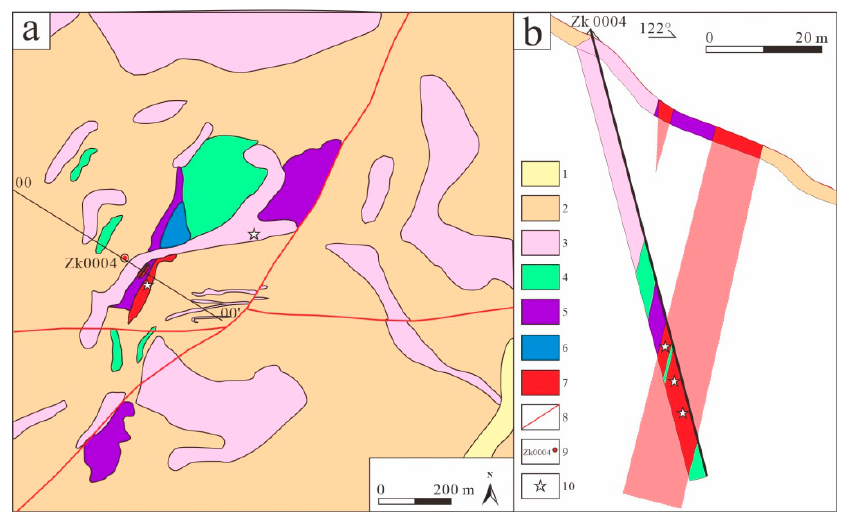
Figure 2. ( a ) Simplified geological map of the Gayahedonggou Cu-Ni deposit. ( b ) Cross sections of 00-00’ in Figure 2a (modified from Sichuan Institute of Nuclear Geology, 2019). 1. Quaternary; 2. Jinshuikou Group; 3. Quartz diorite; 4. Gabbro; 5. Wehrlite; 6. Sulfide mineralization; 7. Fault; 8. Drill core; 9. Sample location.